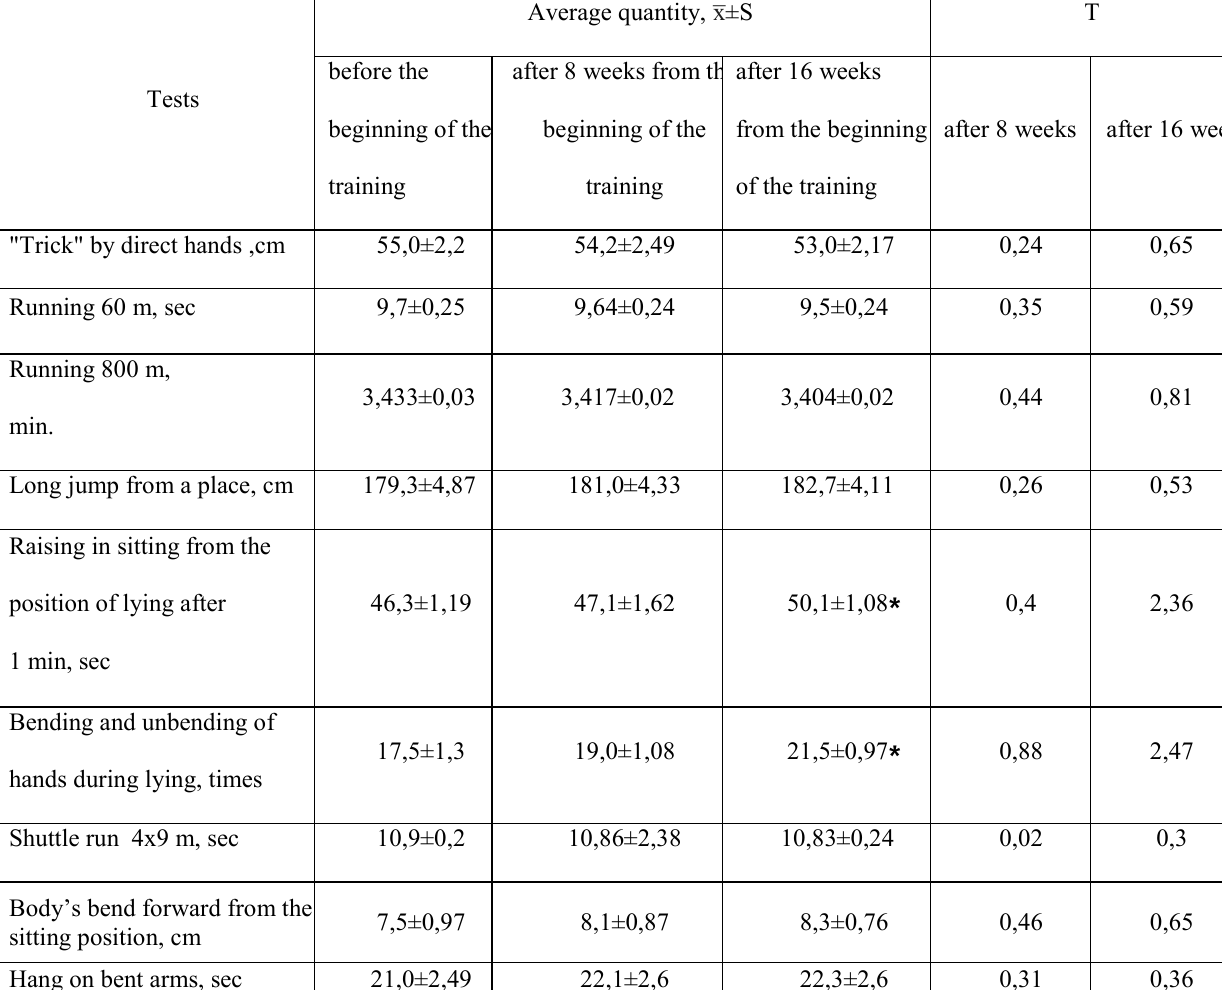
Swimming training influence according to the program of CYSS on general physical preparation of group’s swimmers CG (n=10) Average quantity, x̅ ±S Tests